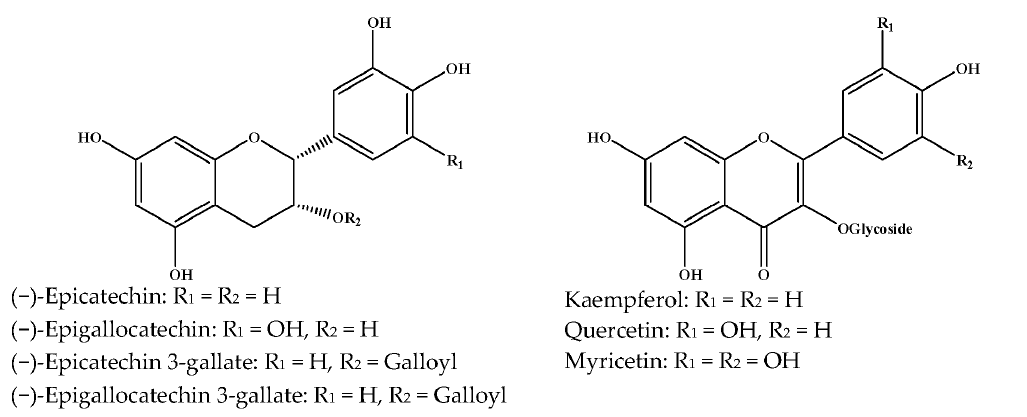
Figure 1. Structures of the major catechins and natural polyphenols.